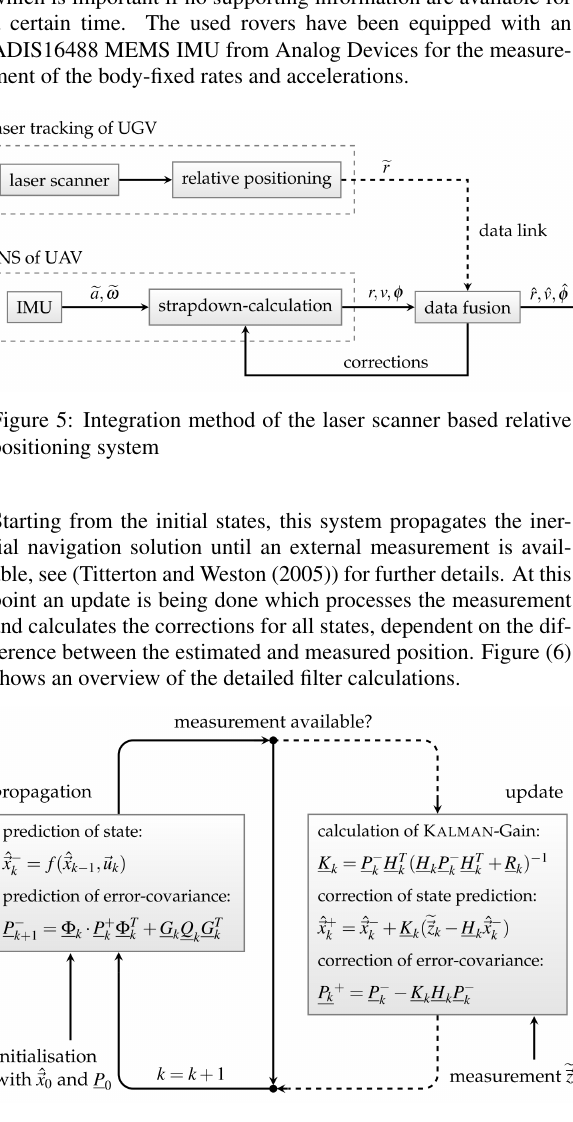
Figure 6: Overview of the Extended Kalman-Filter flow